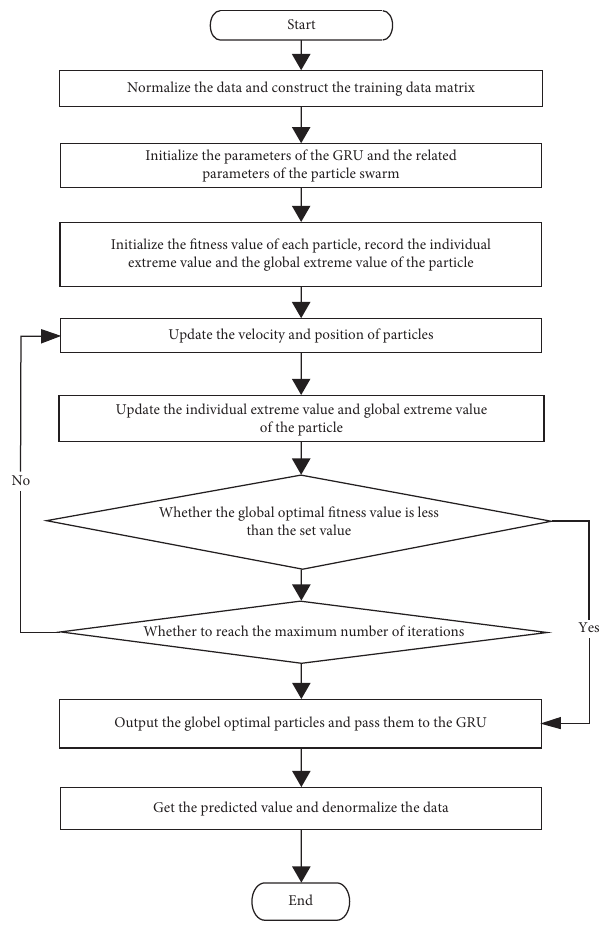
Figure 5: Process of the APSO-GRU prediction